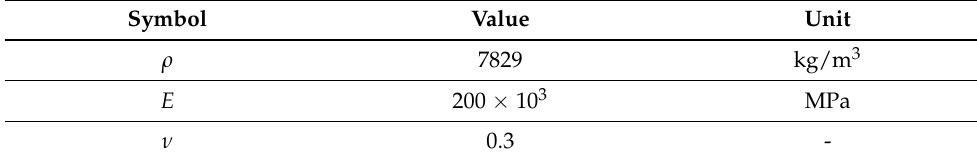
Table 4. Cam and follower mechanical